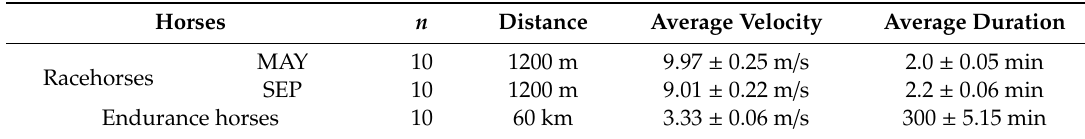
Table 1. Technical parameters of the exercise performed by the horses (means ± SD). Horses n Distance Average Velocity Average Duration MAY 10 1200 m 9.97 ± 0.25 m / s 2.0 ± 0.05 min Racehorses SEP 10 1200 m 9.01 ± 0.22 m / s 2.2 ± 0.06 min Endurance horses 10 60 km 3.33 ± 0.06 m / s 300 ± 5.15